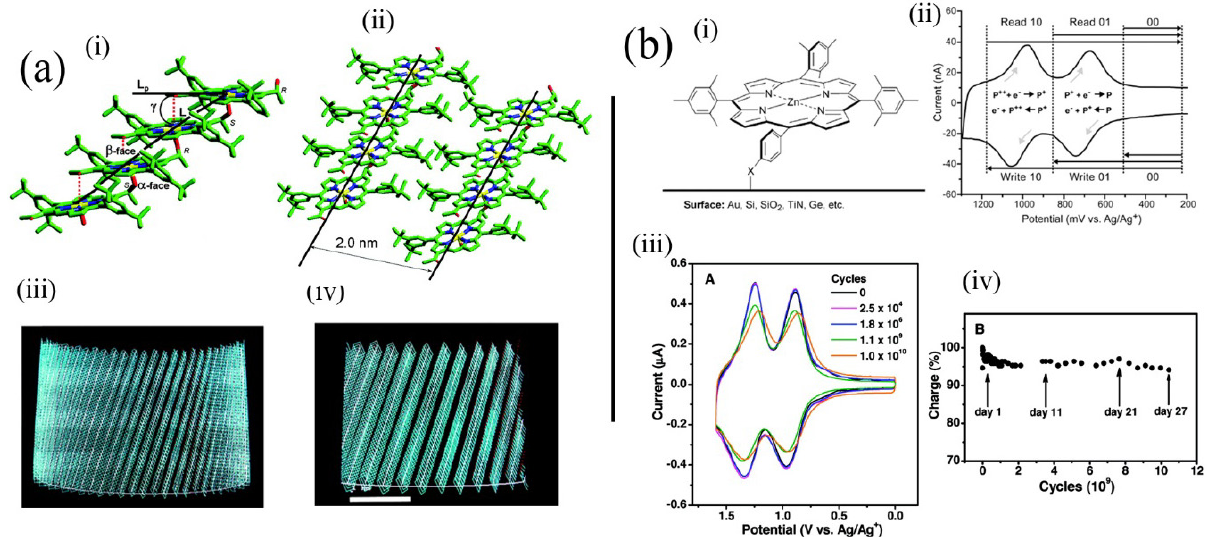
groups coordinate zinc(II) cations in adjacent molecules leading to tapes composed of molecules, which in turn aggregate to form tubules depicted in (iii) and (iv). The 2 nm spacing is similar to regular spacings found in bacterial chlorosomes. Adapted from ref. [38]. Copyright (2005) American Chemical Society; ( b ) (i) Structure of porphyrin applied as a memory element in self-assembled monolayers and (ii) the read-write process based on it. (iii) Voltammetric response upon repeated cycling of the system in (i). (iv) Charge storage integrity over 10 [10] cycles. Adapted from ref. [51]. Copyright (2011) American Chemical